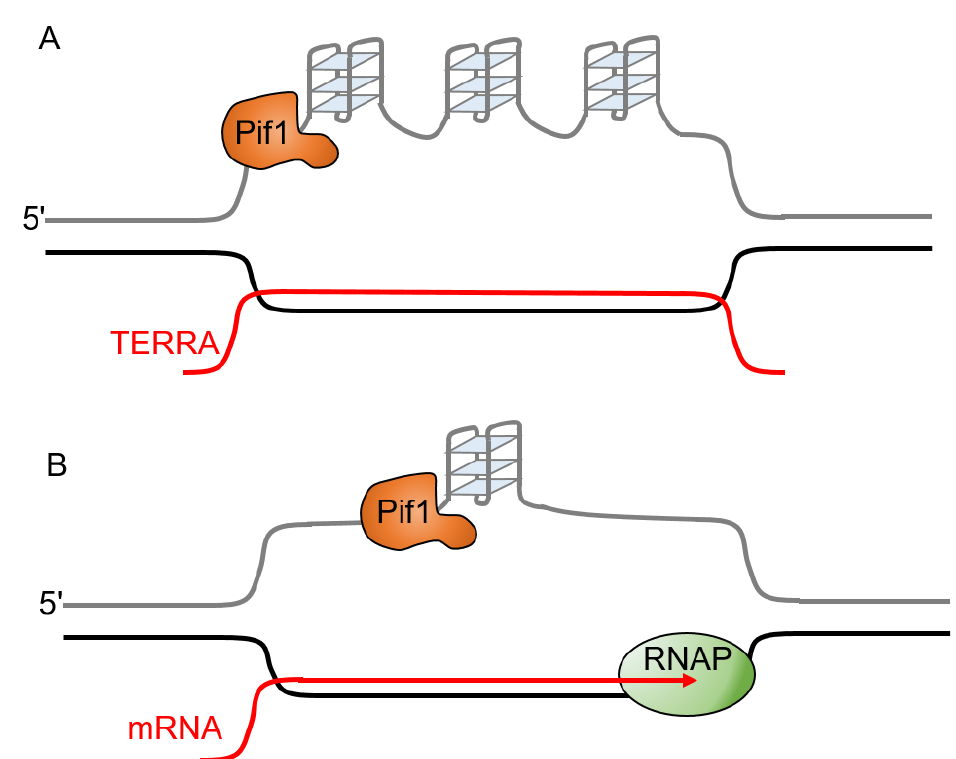
Figure 4. The role of Pif1 at R-loops may be to resolve G4 structures that form on the displaced strand. ( A ) Multiple G4 structures can form on the displaced strand of a telomeric R-loop. ( B ) G4 formation on the displaced strand of a co-transcriptional R-loop is likely to be more limited. In either case, Pif1 (orange triangle) is proposed to resolve the G4 structures on the displaced strand instead of resolving the R-loop itself. Green color shows RNA polymerase.